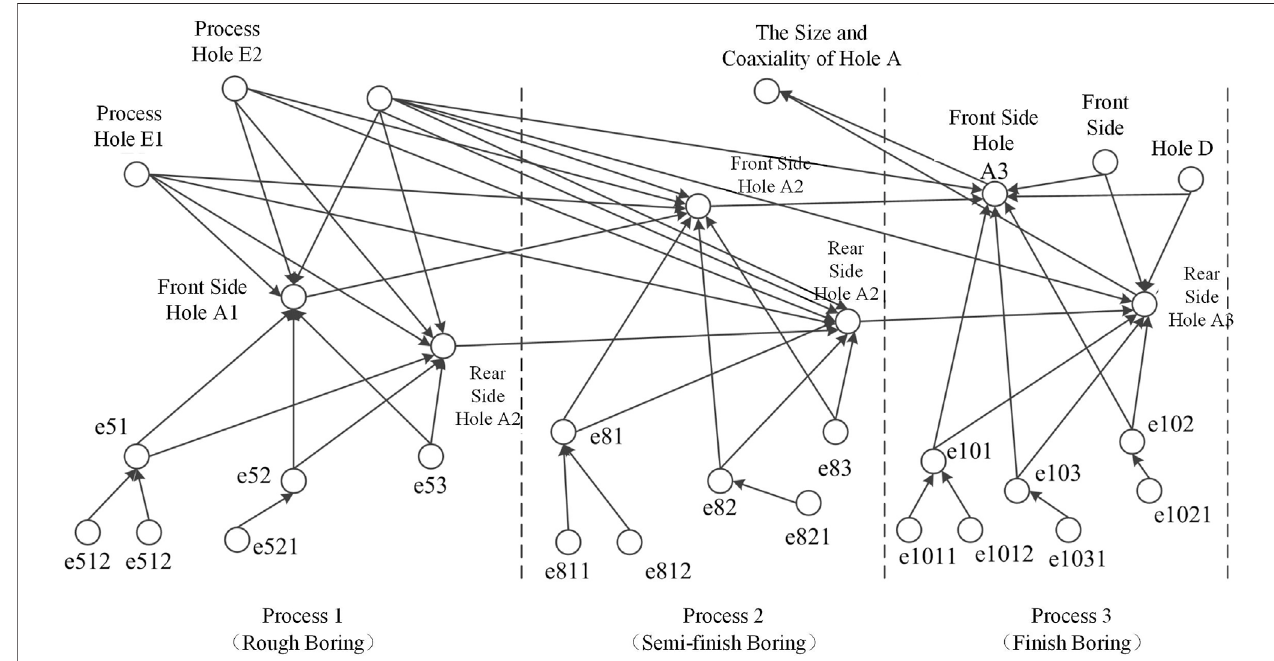
FIGURE 12 | Launcher part machining error propagation network (Liu and Jiang, 2007).